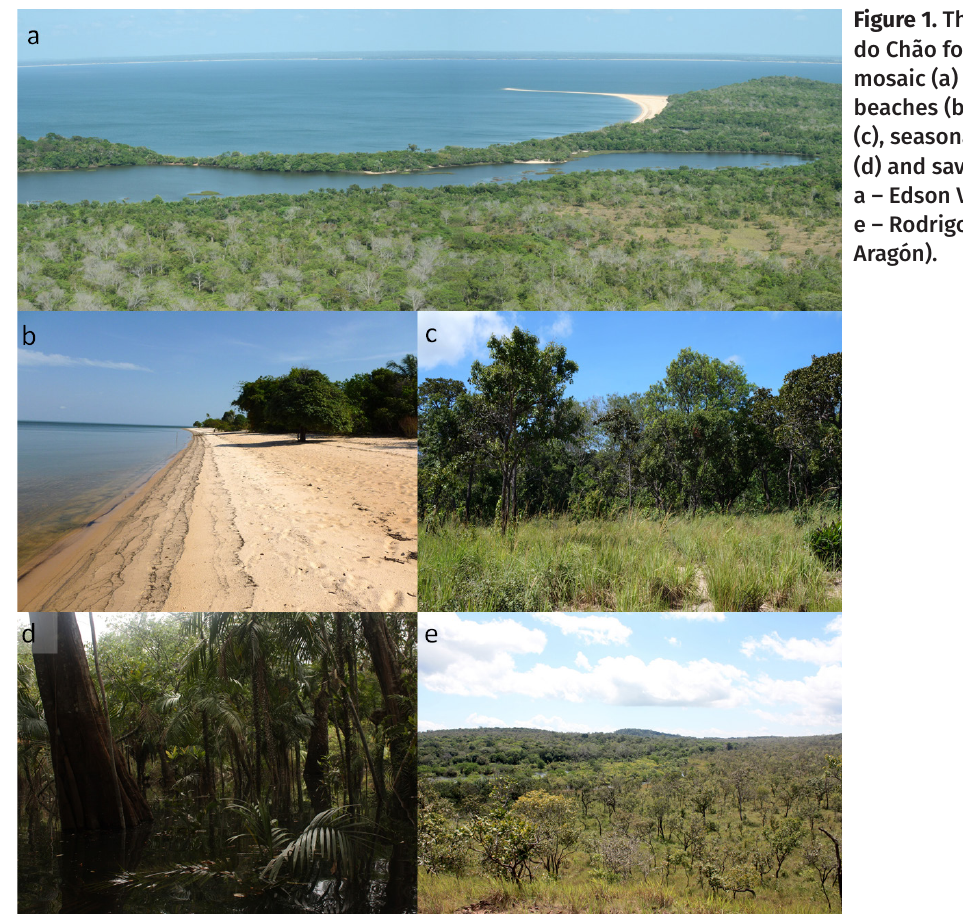
Figure 1. The landscape in Alter do Chão forms a vegetation mosaic (a) comprised of sand beaches (b), forest fragments (c), seasonally-flooded forests (d) and savannas (e).